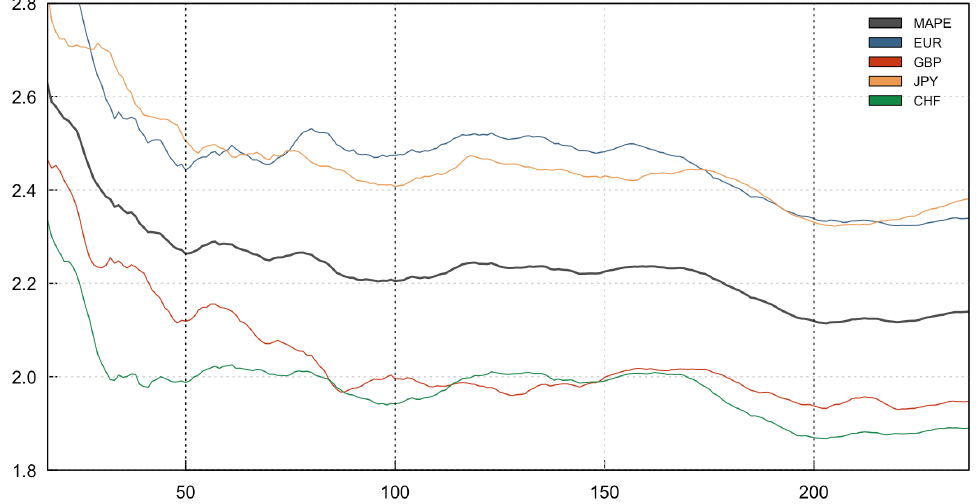
Figure 6. Mean absolute prediction error based on the 12-step-ahead forecast.